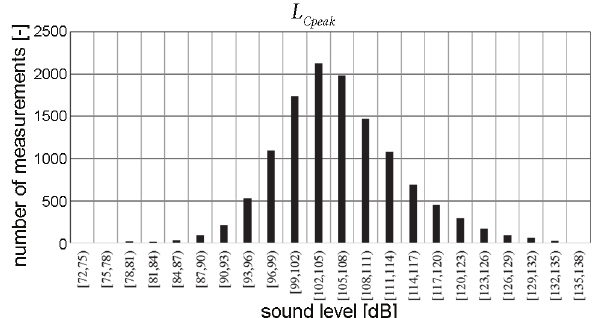
Figure 5. C-weighted peak sound level registered for all